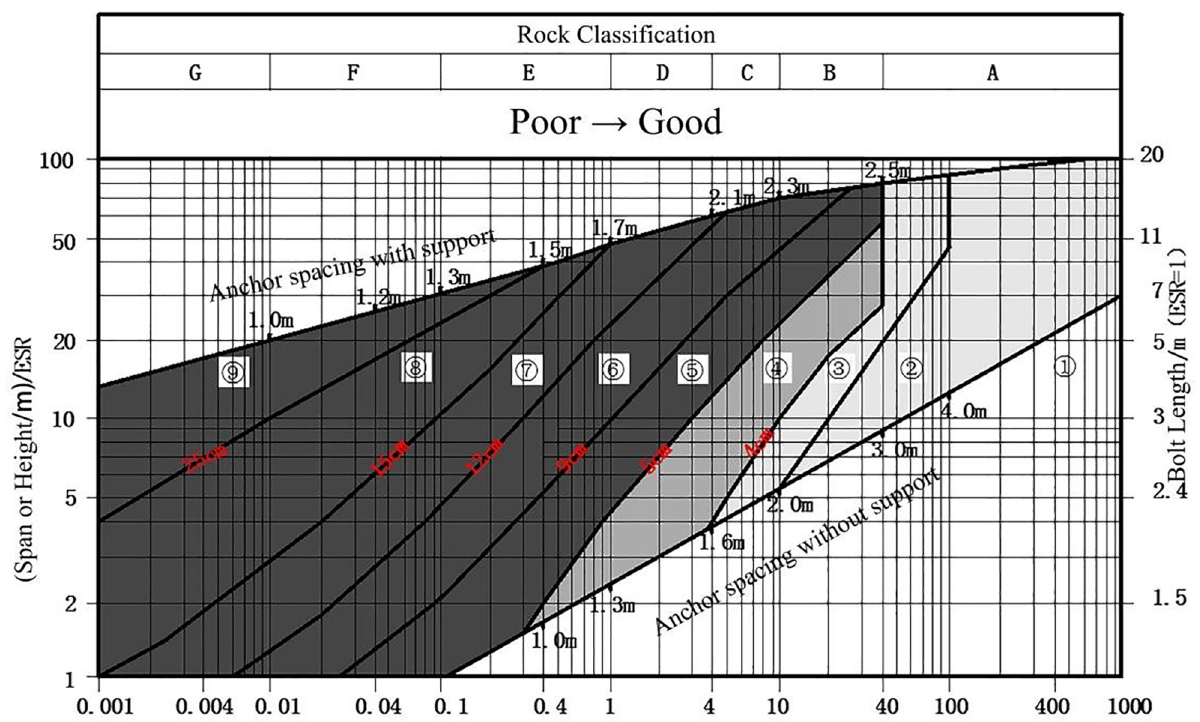
Fig 7. Q system rock classification and support chart. In this figure: ① No support required; ② Point anchor support; ③ System bolt support; ④ System bolt support (plain shotcrete, thickness of 4~5cm); ⑤ System bolt and steel fiber shotcrete, thickness 5~9cm; ⑥ System bolt and steel fiber shotcrete, thickness of 9~12cm; ⑦ System bolt and steel fiber shotcrete, thickness of 12~15cm; ⑧ System bolt and steel fiber shotcrete, thickness > 15cm, plus shotcrete reinforced ribs; ⑨ Mold concrete lining.